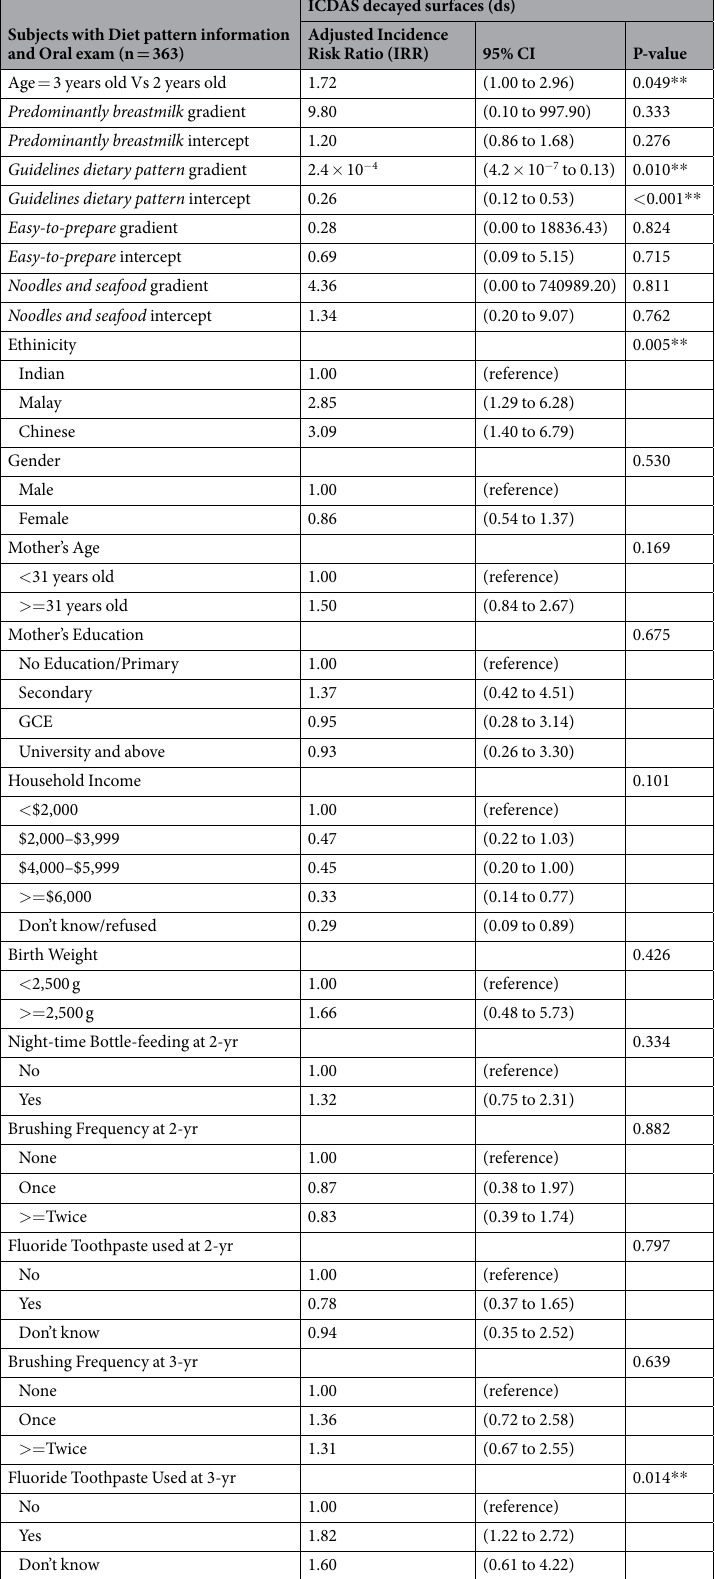
Table 4. Association of dietary pattern trajectories with early childhood